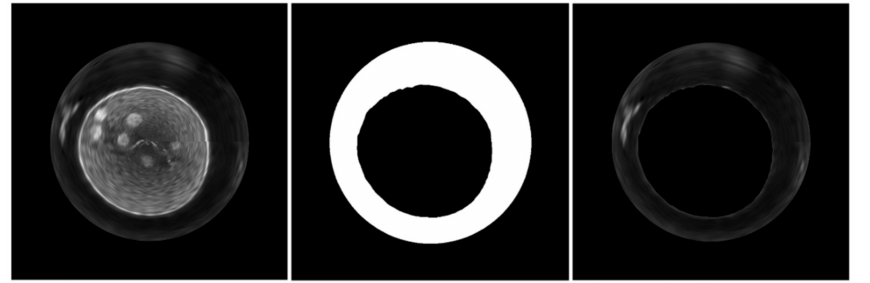
Figure 9. Masking presentation for the calculation of the output value of the mean pixels. Images from left to right: original image, binary mask, masked